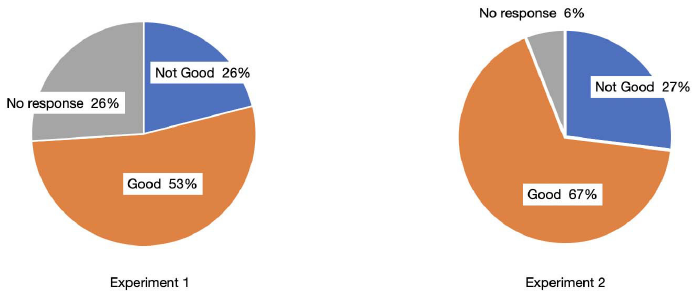
Figure 21. The result of evaluation of the delivered